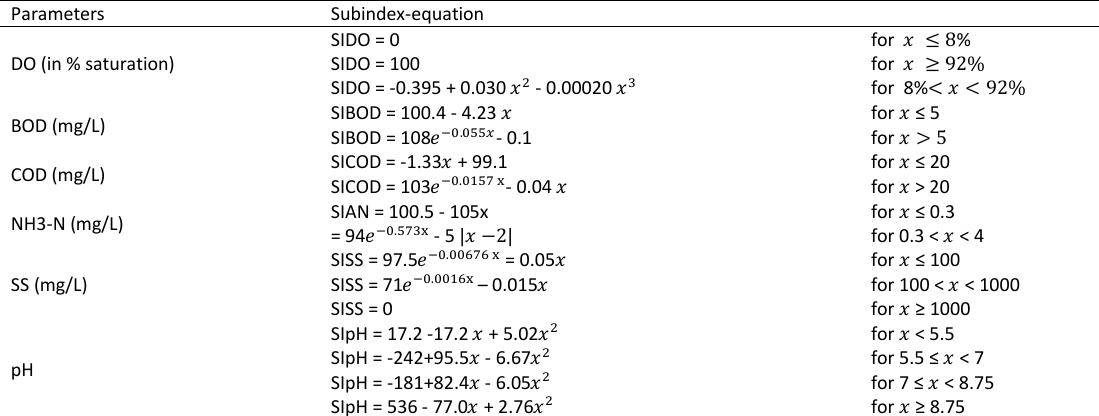
Table 1: The calculation procedure of sub-indices for the local Water Quality Index (DOE, 2007)